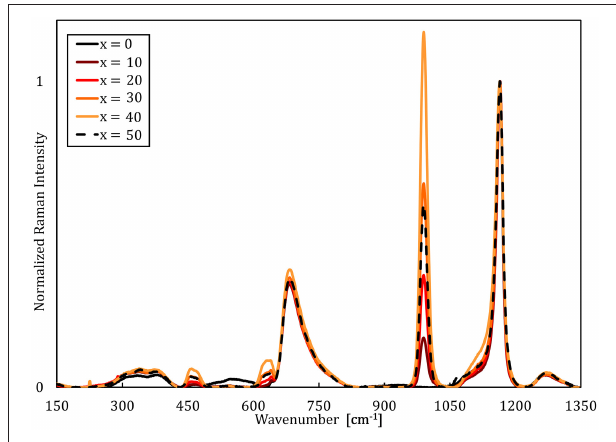
FIGURE 1 | Normalized Raman spectra for the (100–x)NaPO 3 -(x/2)Na 2 SO 4 glasses.